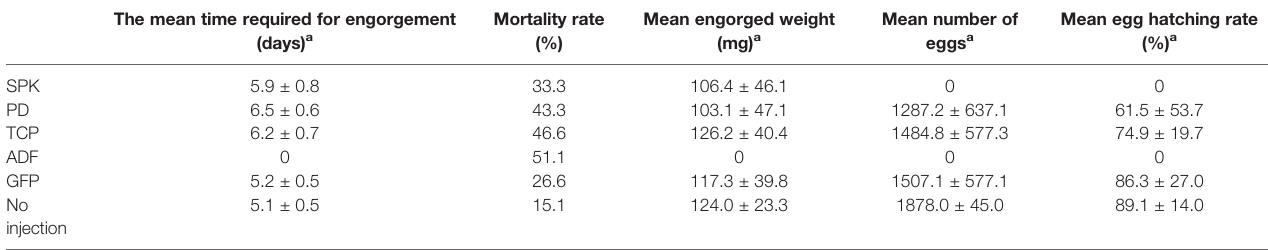
TABLE 2 | The effects of the RNAi on engorgement time, mortality rate, tick weight, number of eggs, and egg hatching rate of Haemaphysalis longicornis ticks. The mean time required for engorgement (days)